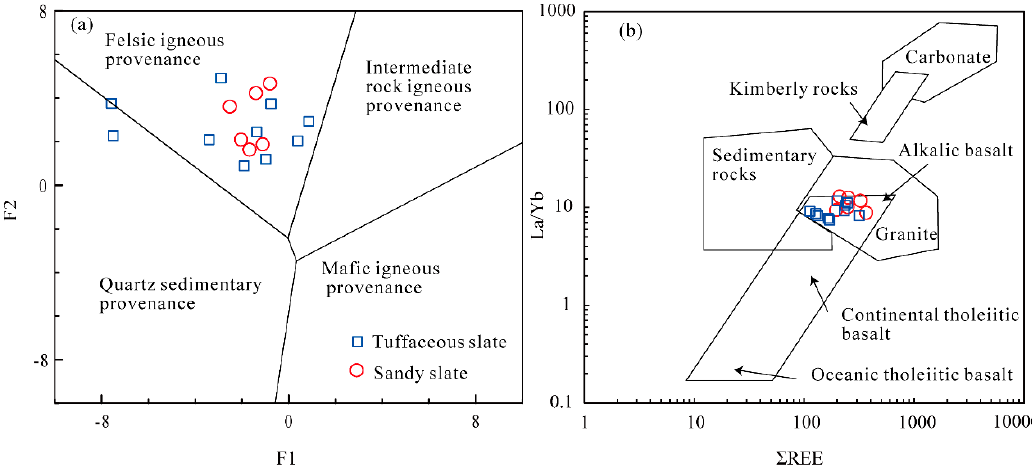
Figure 9. ( a ) F1 vs. F2 and ( b ) Σ REE vs. La / Yb plots for the rocks of Qingshuijiang Formation. Figure 9a,b are modified from [49] and [50], respectively. F1 = − 1.173TiO 2 + 0.607Al 2 O 3 + 0.76TFe 2 O 3 − 1.5MgO + 0.616CaO + 0.509Na 1.142MgO + 0.438CaO + 1.475Na 2 O + 1.426K 2 O −